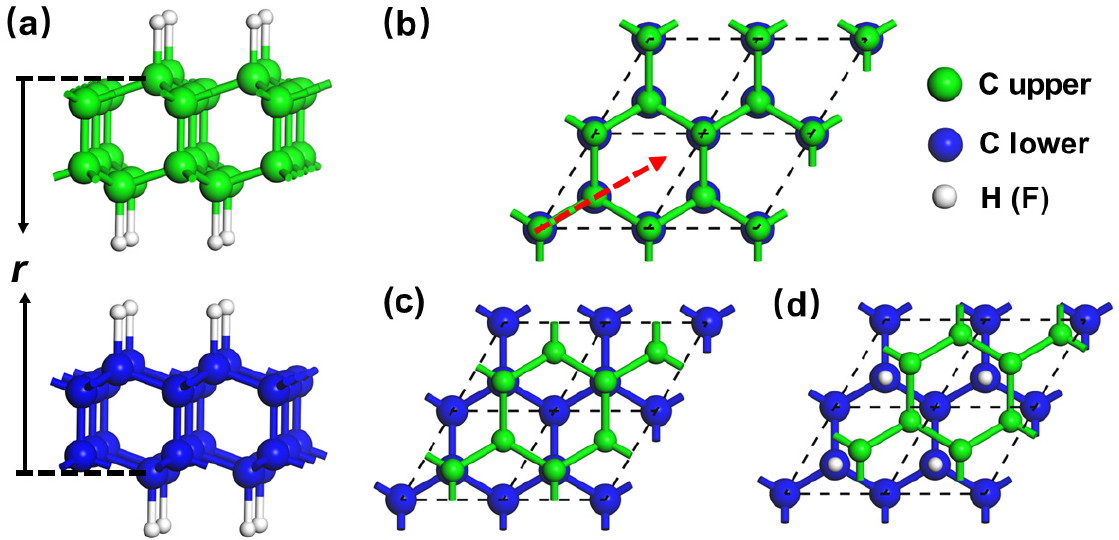
Figure 2. Sliding model. ( a , b ) Represent side and top views of the initial configuration, respectively. The vertical distance between the bottom and top C layers is defined as r . As all interfacial C and H atoms from two layers face each other, the configuration is defined as top stacking. ( c , d ) are defined as hollow and bridge stackings following previous study [49]. To clearly exhibit the stacking characters, the C atoms in different sheets are labeled with different colors.